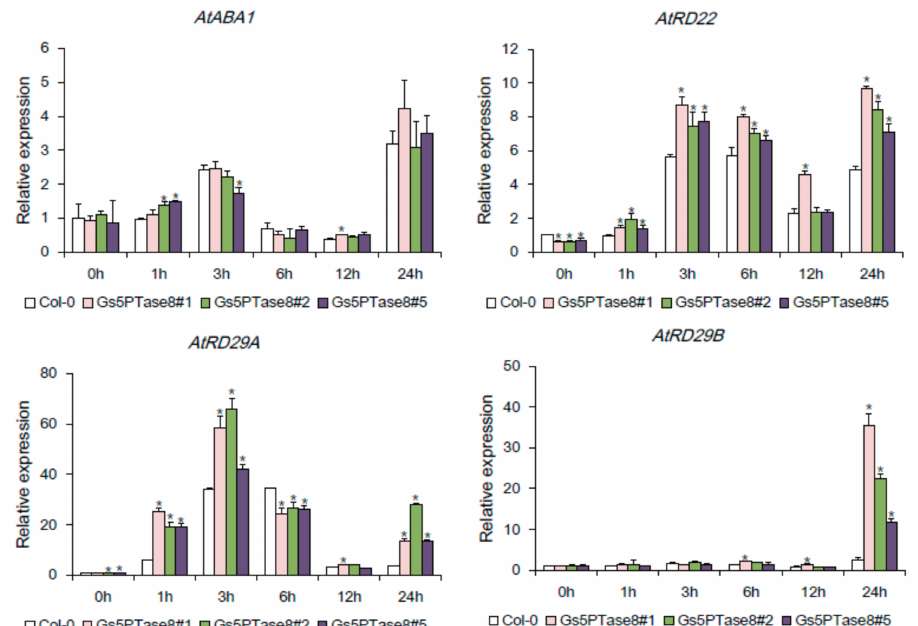
Figure 7. E ff ects of Gs5PTase8 on the expression levels of the stress-responsive genes. The three-week seedlings were treated by 100 mM NaCl in a hydroponic system for 0 h, 1 h, 3 h, 6 h, 12 h, and 24 h. The expression of AtABA1 , AtRD22 , AtRD29A, and AtRD29B were analyzed by qRT-PCR in the three independent Gs5PTase8 -transgenic lines (Gs5PTase8 #1, #2, #3) and the wild type (Col-0). The data were normalized to the reference gene ACT2 . The value of the samples collected from Col-0 at 0h was set at 1. The data were analyzed using ANOVA by the Dunnett’s post hoc test. Asterisk indicates a significant di ff erence between the wild type and the transgenic lines at the same time point ( p <